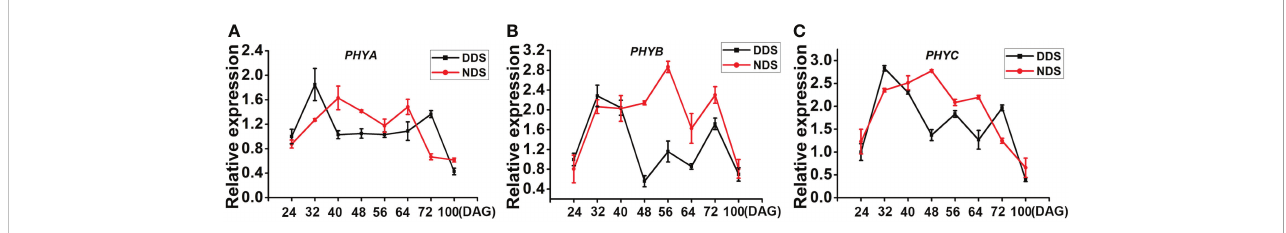
FIGURE 3 The transcript levels of PHYA , PHYB , PHYC decreased under DDS conditions. (A-C) The qRT-PCR analysis of temporal expression in the whole plants PHYA , PHYB , PHYC between DDS and NDS at 24 、 32 、 40 、 56 、 64 、 72 、 100 DAG. Error bars represent mean ± SD (n = 3) where the different letters indicate statistical differences according to Duncan ’ s multiple range test (p ≤